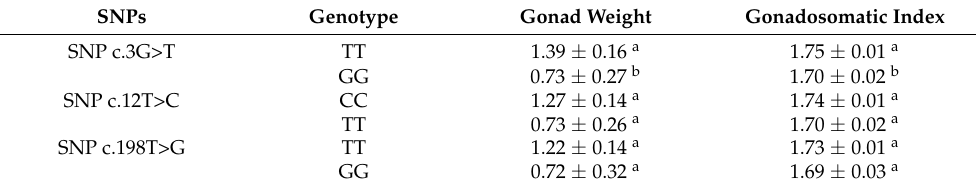
Table 4. Association analysis between kiss1 polymorphism and reproductive